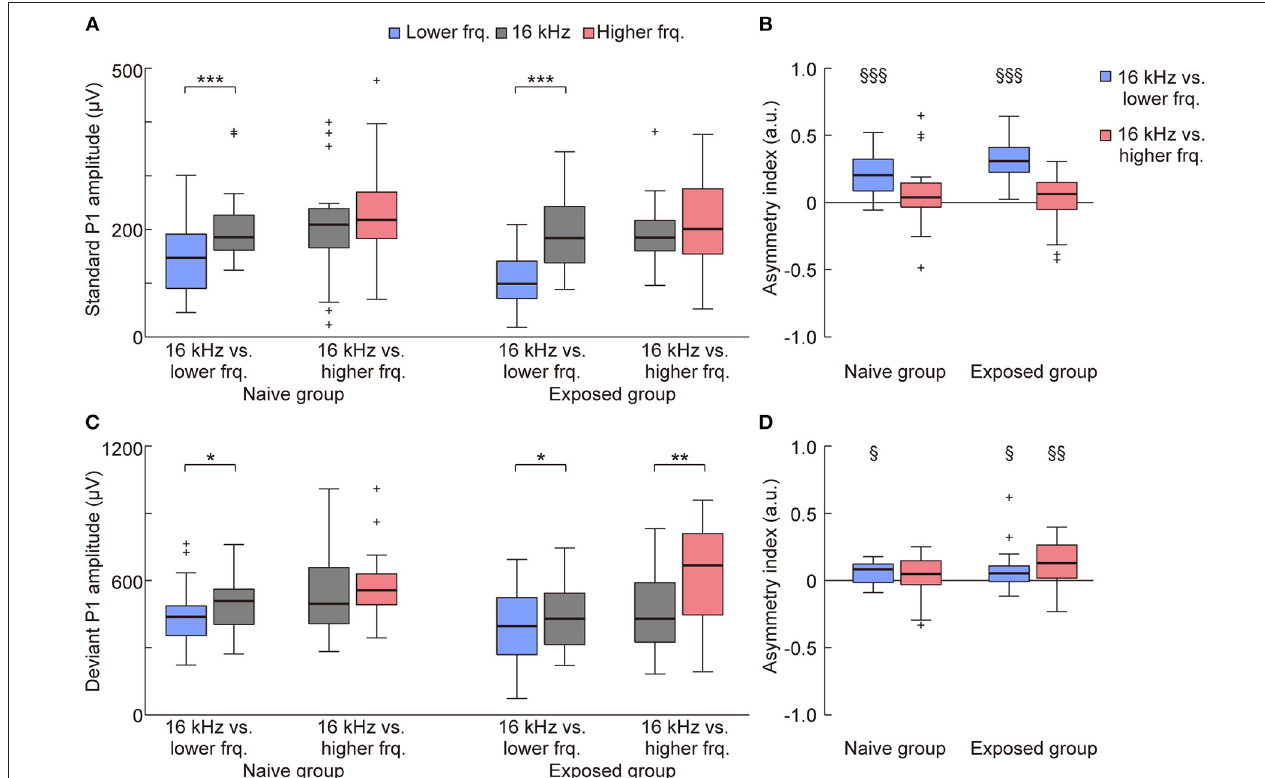
FIGURE 5 | Mere exposure had no effect on the asymmetry of the P1 amplitude. The amplitude and asymmetry index of the (A,B) standard and (C,D) deviant P1 in each condition ( n = 7 per group × 3 tone pairs) is shown. (A) For the standard P1 amplitude, three-way ANOVA showed significant effects for the Relative height of frequency paired with 16kHz (exposed tone for the exposed group) [ F (1,160) = 17.59; p = 0.00024], Direction of change [ F (1,160) = 14.13; p = 0.000045], and Group of rats [ F (1,160) = 7.16; p = 0.0082], and for the two-way interaction Relative height × Direction of change [ F (1,160) = 5.69; p = 0.018]. post-hoc tests revealed that the amplitude responding to the lower tone was smaller than 16kHz in the same tone pairs. (B) For the asymmetry index of the standard P1 amplitude, two-way ANOVA also showed significant effects for Relative height of frequency paired with 16kHz [ F (1,80) = 25.34; p = 0.0000029] and for the two-way interaction Relative height × Group of rats [ F (1,80) = 4.48; p = 0.037]. post-hoc tests revealed the frequency-dependent asymmetry in the tone pairs of 16kHz and lower frequencies. (C) For the deviant P1 amplitude, three-way ANOVA showed significant effects for Relative height of frequency paired with 16kHz [ F (1,160) = 5.49; p = 0.020], and Direction of change [ F (1,160) = 16.45; p = 0.000078]. post-hoc tests revealed the asymmetric amplitude in three conditions. (D) For the asymmetry index of deviant P1, two-way ANOVA showed significant effects for Group of rats [ F (1,80) = 3.98; p = 0.049]. Most importantly, post-hoc Wilcoxon two-sided rank-sum tests found no significant difference between groups in both the amplitude and asymmetry index ( p > 0.05), indicating that tone exposure caused no plasticity in the P1 amplitude after exposure, while it caused rapid reversal of the frequency-dependent asymmetry of mismatch negativity. Statistical significance: * p < 0.05; ** p < 0.01; *** p < 0.001 (Wilcoxon two-sided signed-rank test), § p < 0.05; §§ p < 0.01; §§§ p < 0.001 (Wilcoxon two-sided signed-rank test vs. zero). Lower frq, lower frequency; Higher frq, higher frequency.